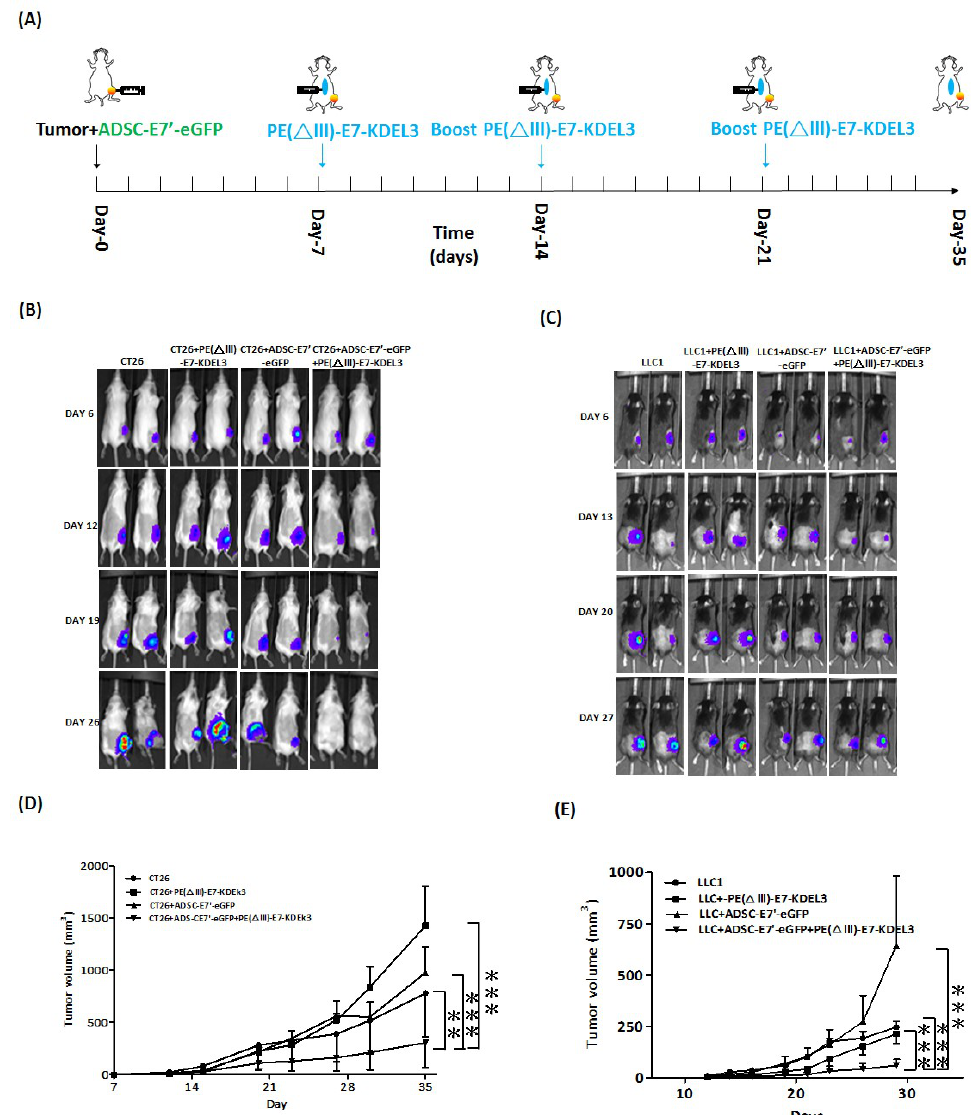
Figure 2. The tumor inhibition of the combined treatment by subcutaneously inoculated ADSC-E7’-eGFP and the protein vaccine. ( A ) Time course of the experiment. Representative bioluminescence images of mice subcutaneously injected with ( B ) 2 × 10 5 CT26 cells with indicated treatment or ( C ) 2 × 10 5 LLC1 cells with indicated treatment. Tumor volume measurements of syngeneic tumor models were conducted at indicated days after subcutaneous injection of ( D ) CT26 cells or ( E ) LLC1 cells; ** p < 001; *** p < 0.001 using two-way ANOVA.